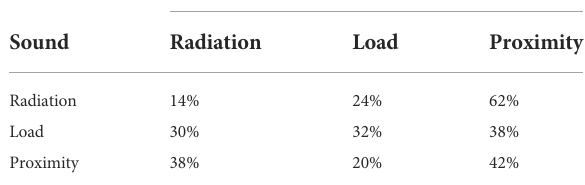
TABLE 1 Table showing the proportion of data features that the participants associated with each abstract sound. Identi fi ed as